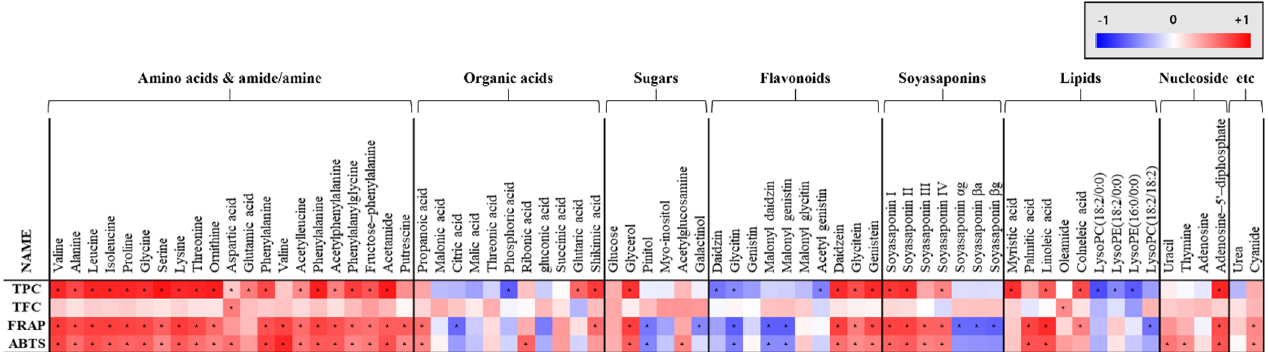
Figure 4. Total flavonoid, phenolic contents, and antioxidant activity tests. ( A ) 2,2-azino-bis-(3-ethylbenzothiazoline-6-sulfonic acid) diammonium salt (ABTS) and ( B ) ferric reducing antioxidant power (FRAP), as well as ( C ) total flavonoid contents (TFC) and ( D ) total phenolic contents (TFC). S, soy; C, cheonggukjang; M, meju; D, doenjang. Values are expressed as the average of three biological replicates ( n = 3). Bar graphs denoted by the same letter were not significantly different, according to Duncan’s multiple range test ( p -value < 0.05).